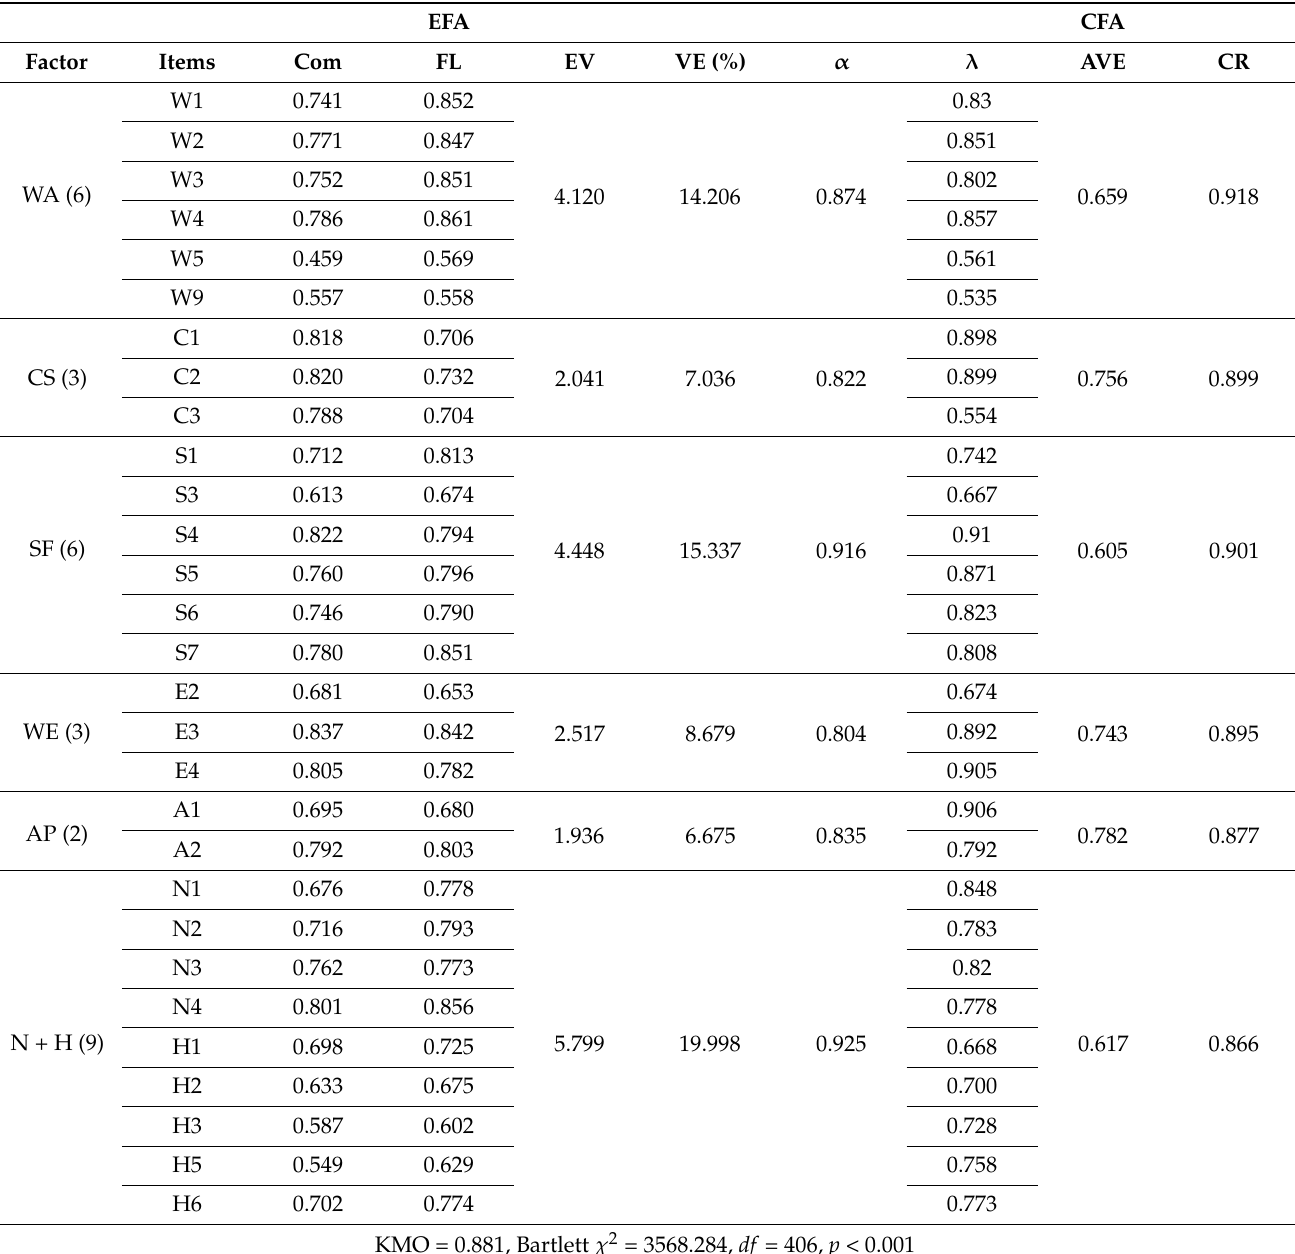
Table 2. Exploratory factor analysis (EFA) and confirmatory factor analysis (CFA). EFA